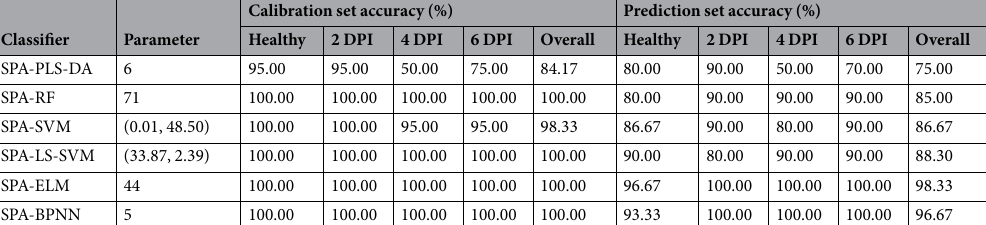
Table 1. Overall and individual class classification accuracies of machine-learning classifiers with effective wavelengths. a a Parameter: number of LVs for partial least squares-discrimination analysis (PLS-DA), number of forest trees for random forest (RF), (C, g) for support vector machine (SVM), ( γ , σ 2 ) for least squares support vector machine (LS-SVM), number of nods for extreme learning machine (ELM), and number of neurons in the hidden layer for back propagation neural network (BPNN).